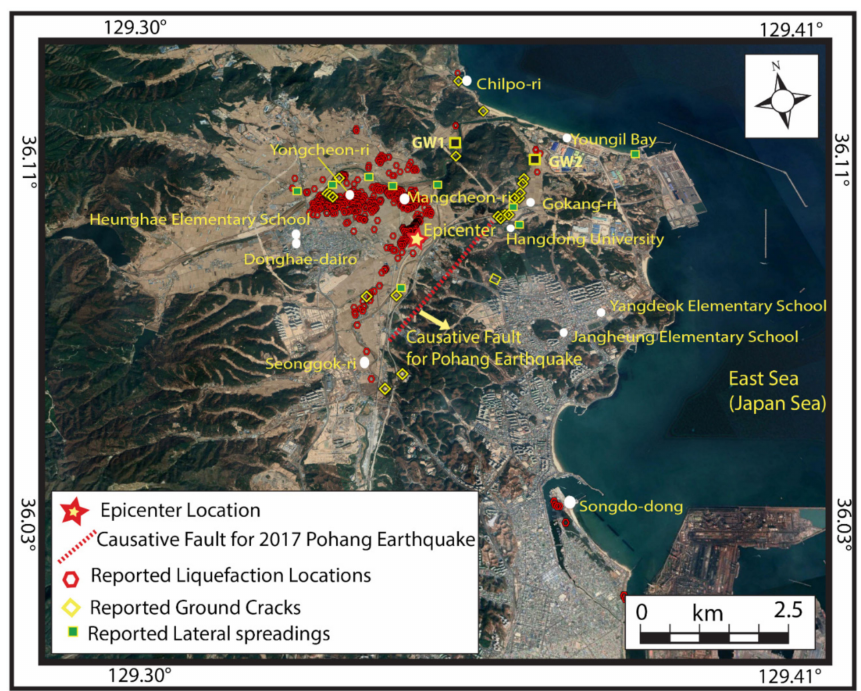
Figure 3. Distribution of secondary e ff ects caused by the Pohang earthquake. The red polygon indicates the reported liquefaction locations (taken from field survey and satellite images), whereas the yellow squares indicate the location of reported ground cracks / lateral spreading during the 2017 Pohang earthquake (modified from